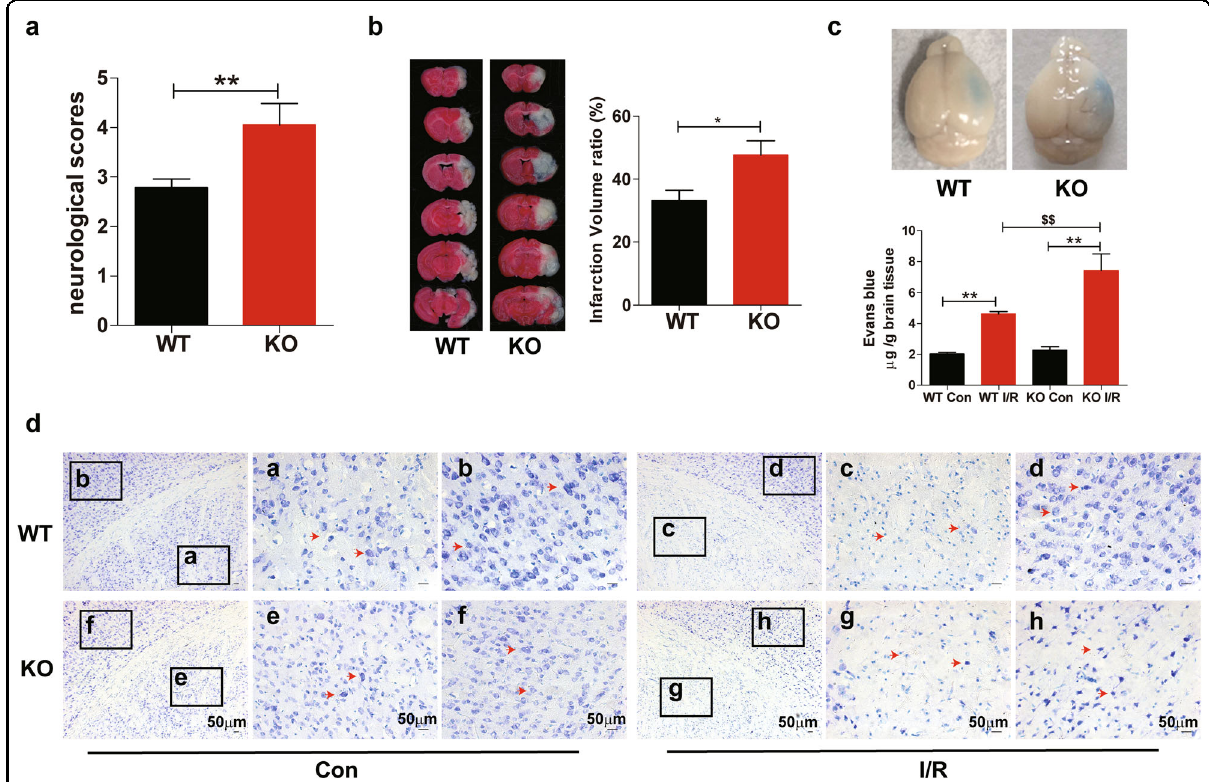
Fig. 2 Loss of FtMt exacerbates cerebral I/R-induced brain damage. Wild-type and FtMt-knockout mice were subjected to MCAO for 90 min and subsequent reperfusion for 24 h. a After 24 h of reperfusion, the neurologic de fi cit scores of wild-type and Ftmt -knockout mice were compared ( n = 15). b Infarct volumes were compared between wild-type ( n = 5) and Ftmt -knockout mice ( n = 6) by TTC staining of coronal sections. c Representative images (upper panels) and quanti fi cation (lower panels) of Evans blue dye extravasation in wild-type or Ftmt -knockout mice at 24 h after I/R ( n = 5). d Nissl staining was performed after 90 min of MCAO and 24 h of reperfusion, and the I/R sides and control (Con) sides of wild-type and Ftmt -knockout mice were compared. The red arrows denote the altered Nissl bodies and degenerated neurons ( n = 3). WT, wild-type mice; KO, Ftmt -knockout mice. The results are presented as the mean ± SEM. * /$ P < 0.05, ** /$$ P <